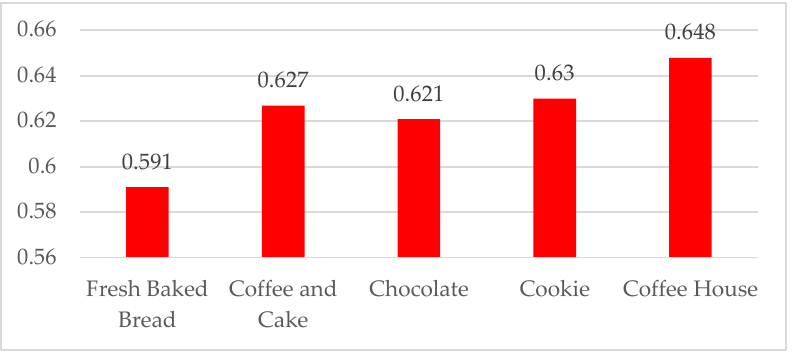
Figure 10. Bias score in measuring the effect of aromas on emotional bias (engagement).